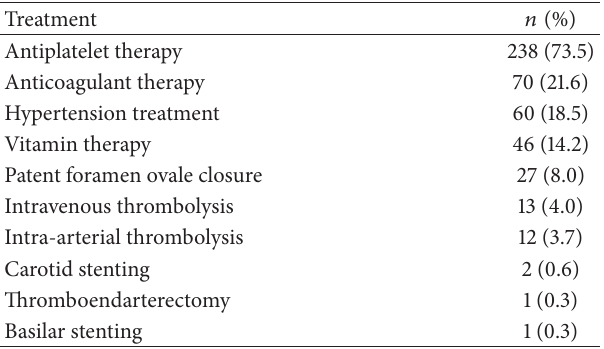
Table 2: Therapeutic approach in young patients with ischemic